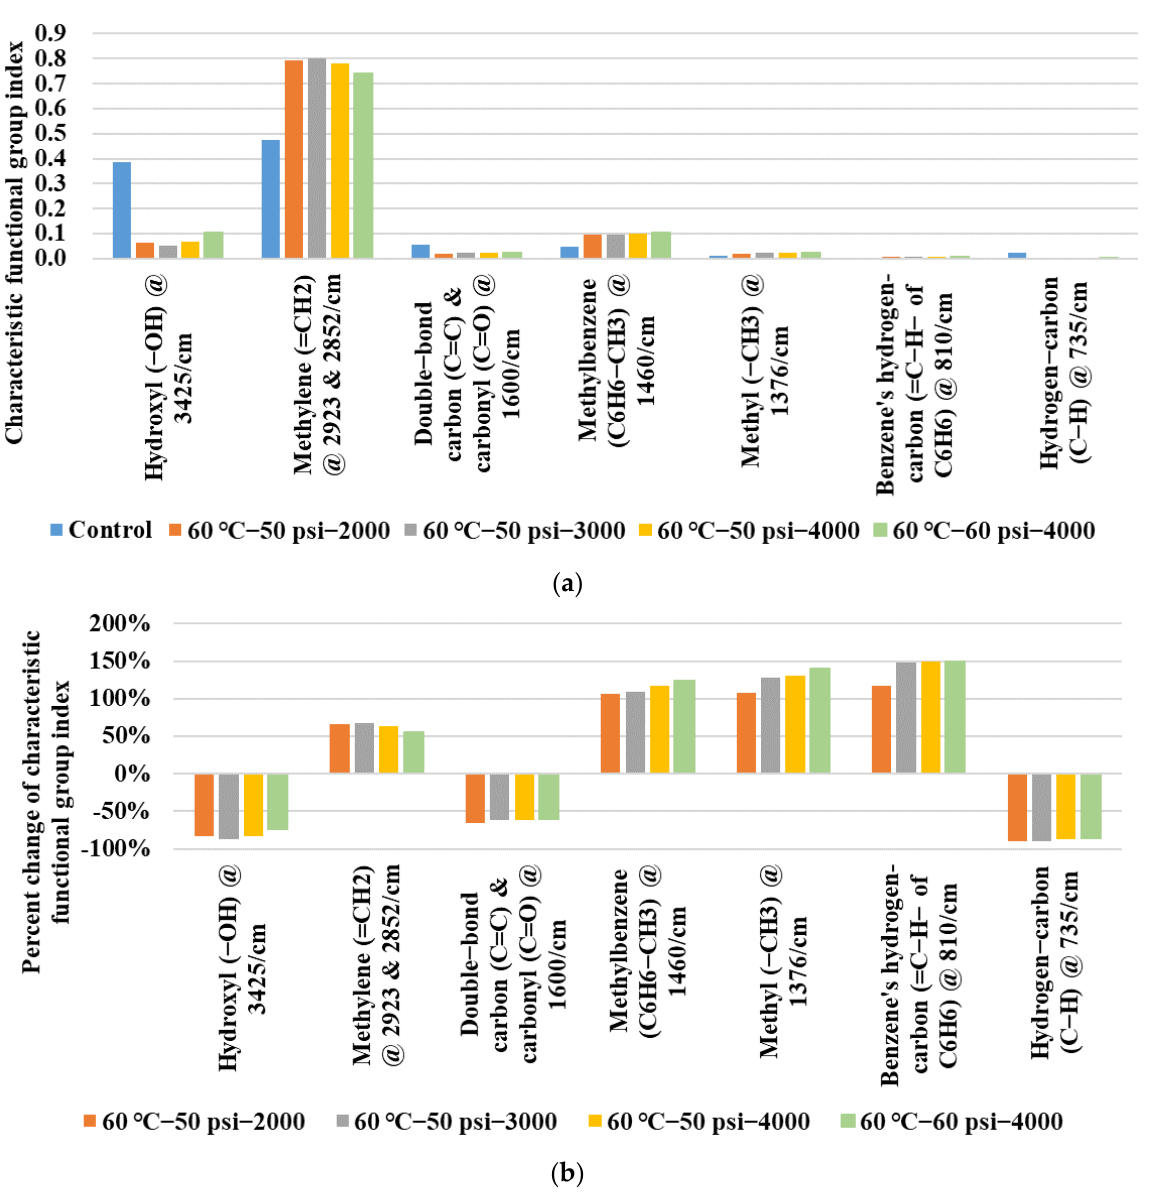
Figure 15. Characteristic functional group index of different types of asphalt binder: ( a ) Characteristic functional group index; ( b ) Percent change in characteristic functional group index.